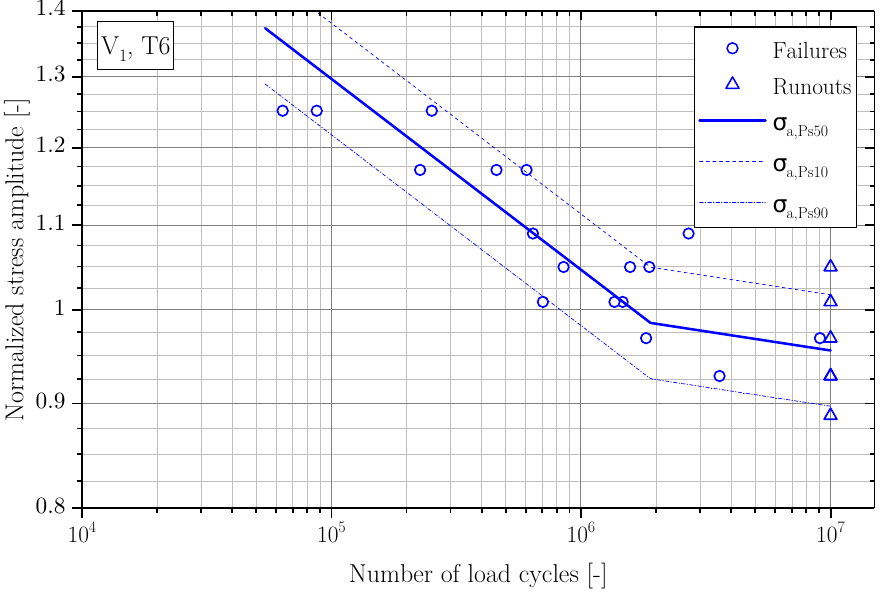
Figure 8. S/N curve of specimen B (evaluation only first failures). Table 2. Results of the fatigue tests of specimen A and